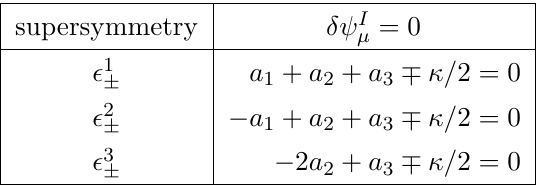
Table 7 . Supersymmetry equations for N = 3